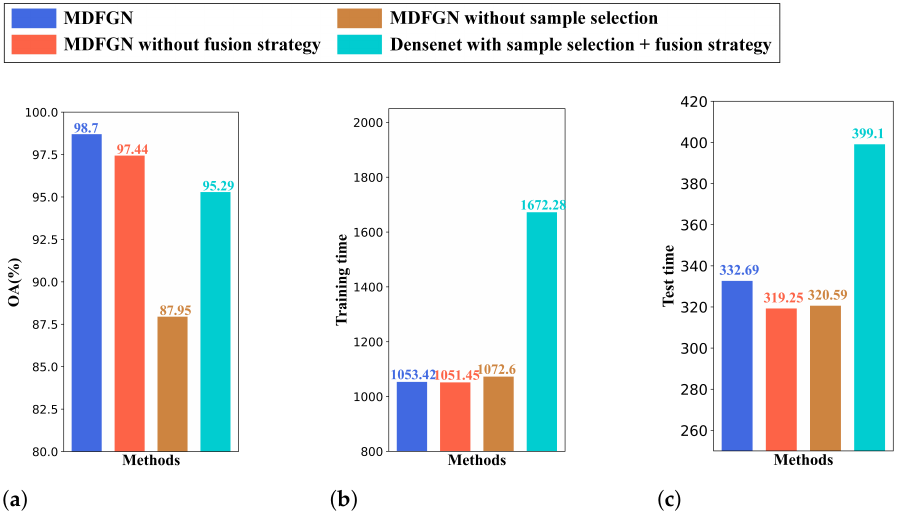
Figure 19. Overall accuracies, training time and test time of different networks on AIR-Flev